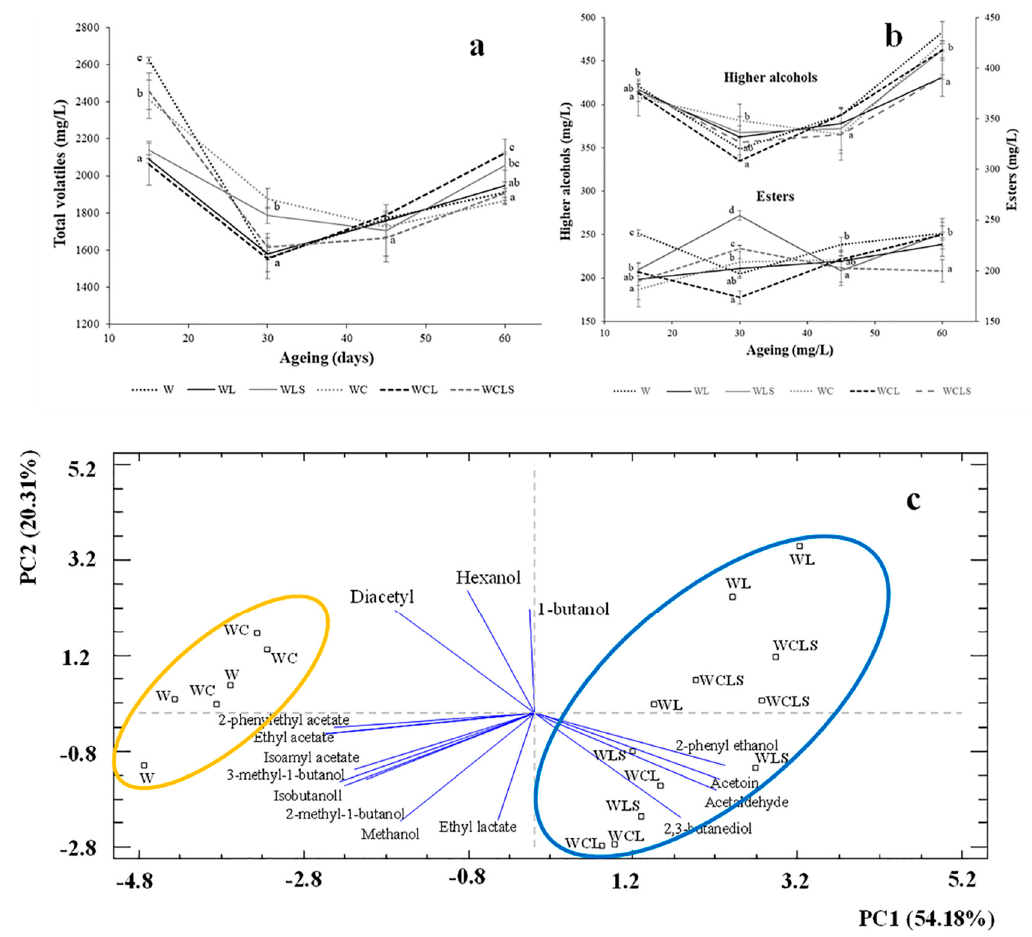
Figure 5. ( a ) Evolution of fermentative volatile compounds (mg/L) and ( b ) increase in higher alcohols and evolution of total ester compounds. ( c ) Principal component analysis (PCA) of the volatile compounds. Mean ± standard deviation of three replicates. W—control wine; WL—wine with lees; WLS—wine with sonicated lees; WC—wine with oak chips; WCL—wine with lees and oak chips; WCLS—wine with sonicated lees and oak chips. Different letters in axes X in figures ( a ) and ( b ) indicate values with statistical significant differences ( p < 0.05).